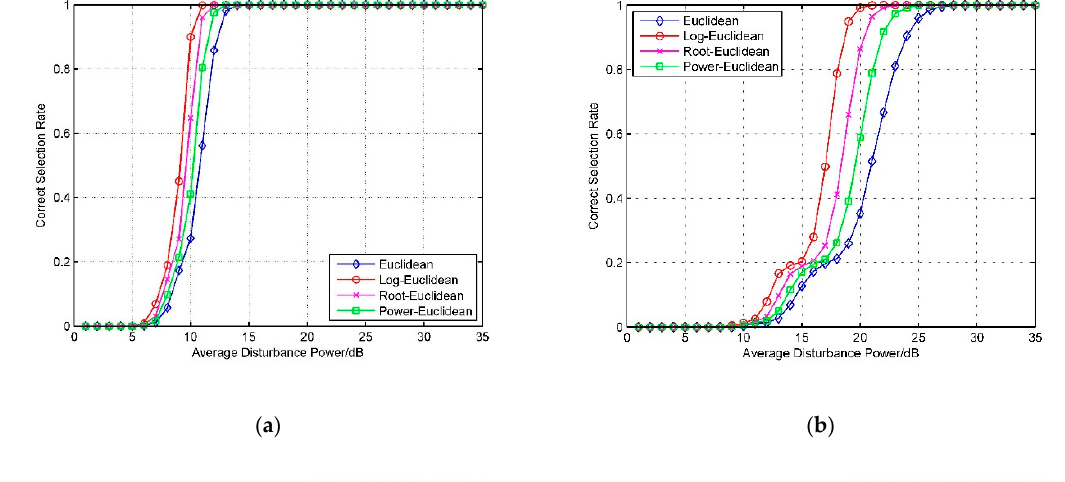
= 0.20, p = 1, N = 8, 0 disturbance (cid:110) (cid:111) (cid:110) (cid:111) (cid:110) (cid:111) (cid:110) (cid:111) c ∈ { 0.13 ± 0.01 } , ∈ { 0.30 ± 0.01 } ; ( b ) ∈ { 0.15 ± 0.01 } , ∈ f d f d f d f d o ,1 o ,2 o ,1 o ,2 (cid:110) (cid:111) (cid:110) (cid:111) (cid:110) (cid:111) (cid:110) (cid:111) ∈ { 0.15 ± 0.01 } , ∈ { 0.27 ± 0.01 } ; ( d ) ∈ { 0.15 ± 0.01 } , ∈ { 0.25 ± 0.01 } f d f d f d f d o ,1 o ,2 o ,1 o ,2